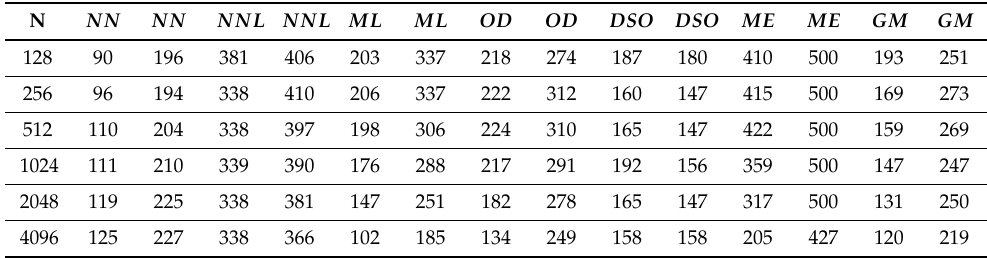
Table 4. ¯ R (multiplied by 10 3 ) for all models and all NLERs for the different fusion methods, learning base (left) and test base